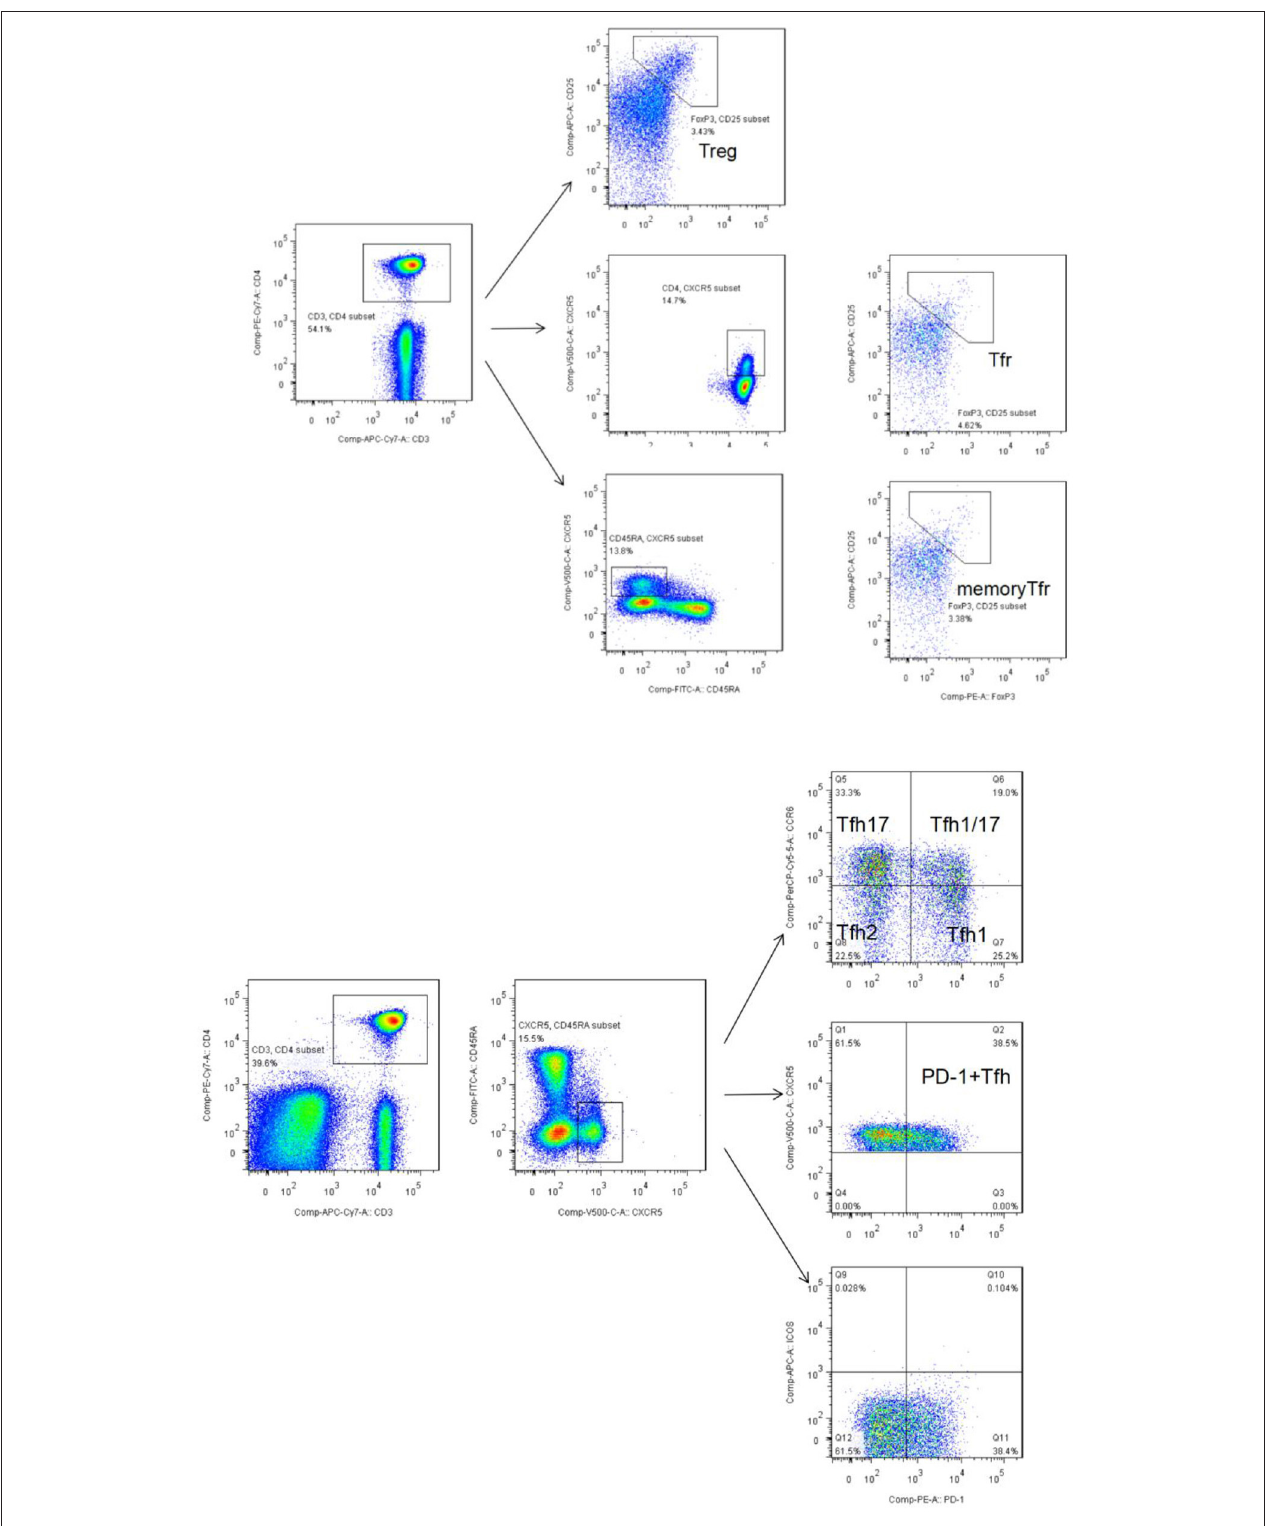
FIGURE 1 | (A) Flow cytometry gating strategy for Tfr-like cells (CD3 + CD4 + CD25 + CXCR5 + FoxP3 + ) and mTfr-like cells (CD3 + CD4 + CD25 + CXCR5 + CD45RA − FoxP3 + ). A total of 50,000 CD4 + T cells were collected. (B) Flow cytometry gating strategy for CD3 + CD4 + CXCR5 + CD45RA − Tfh-like cells, CD3 + CD4 + CXCR5 + CD45RA − PD-1 + Tfh-like cells, and Tfh-like cell subsets, including Tfh1-like cells (CXCR3 + CCR6 − ), Tfh2-like cells (CXCR3 − CCR6 − ), Tfh17-like cells (CXCR3 − CCR6 + ), and Tfh1/17-like cells (CXCR3 + CCR6 + ). A total of 10,000 Tfh-like cells were collected. Tfr-like, T follicular regulatory-like; mTfr-like, memory T follicular regulatory-like; Tfh-like, T follicular helper-like; Treg, T regulatory.